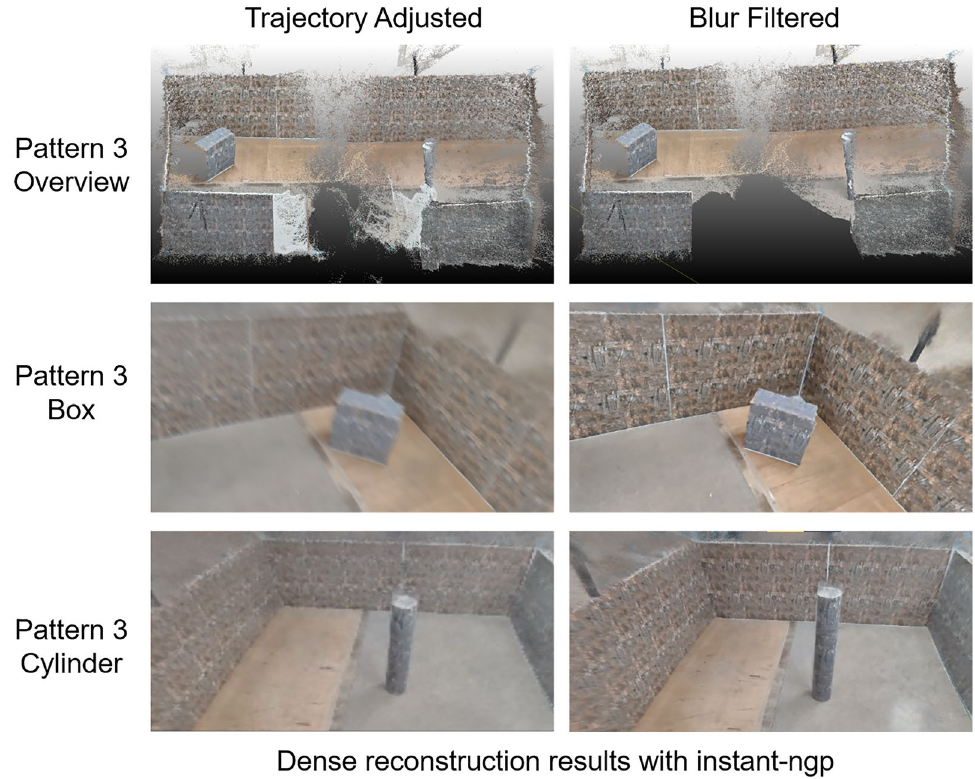
Fig. 16 Reconstruction results by instant-ngp with trajectory-adjusted dataset (left) and blur filtered dataset (right) under setup pattern 3